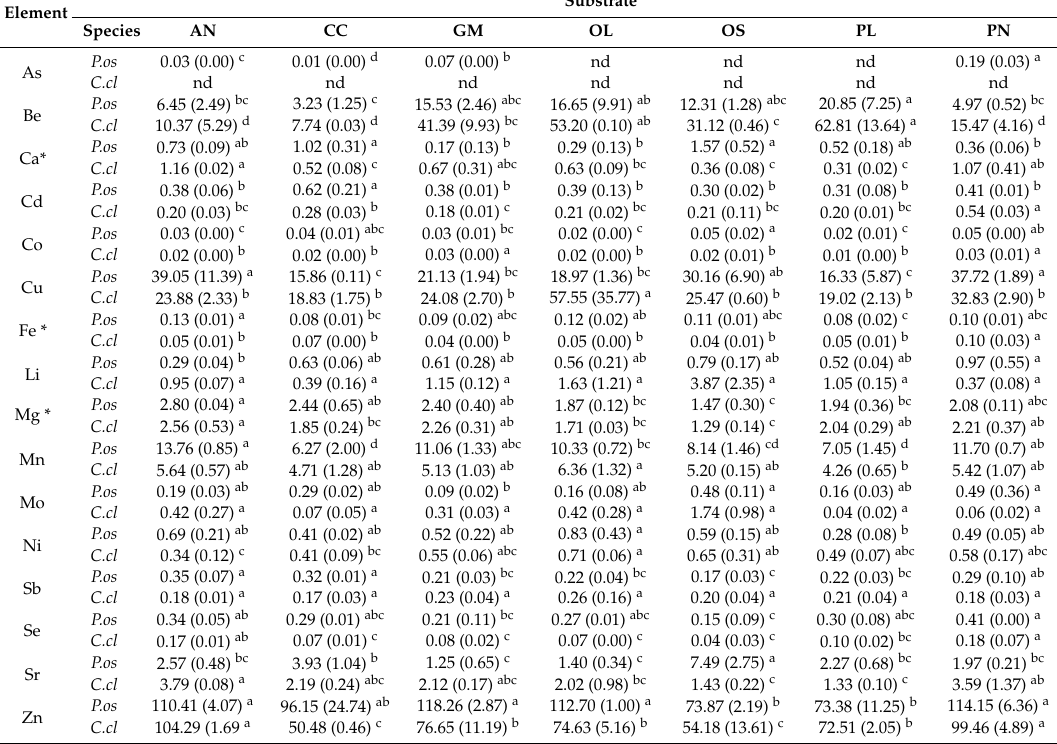
Table 2. Elements’ concentrations in Cyclocybe cylindracea LGAM 496 [ C.cl ] and Pleurotus ostreatus LGAM 1123 [ P.os ] mushrooms produced in seven cultivation substrates. AN: almond and walnut